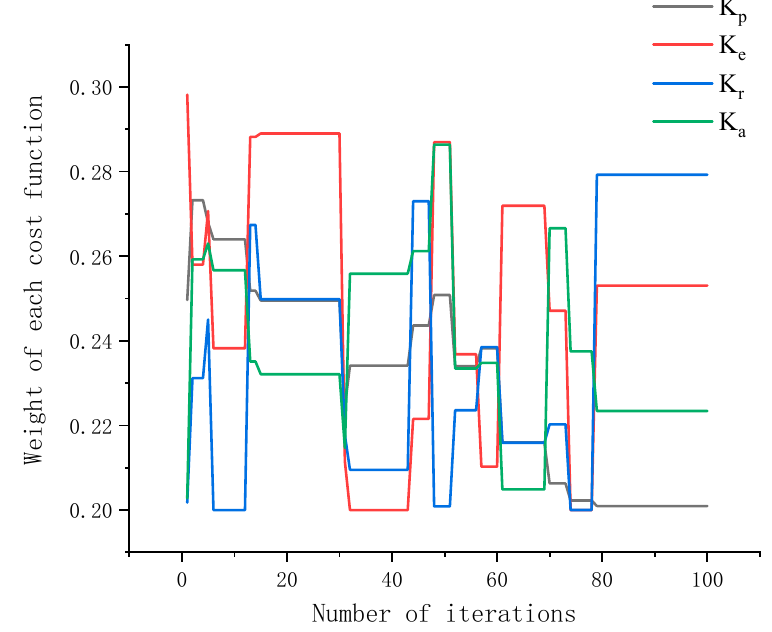
Figure 35. The weight of cost function of EPA-PSO algorithm after 100 iterations.